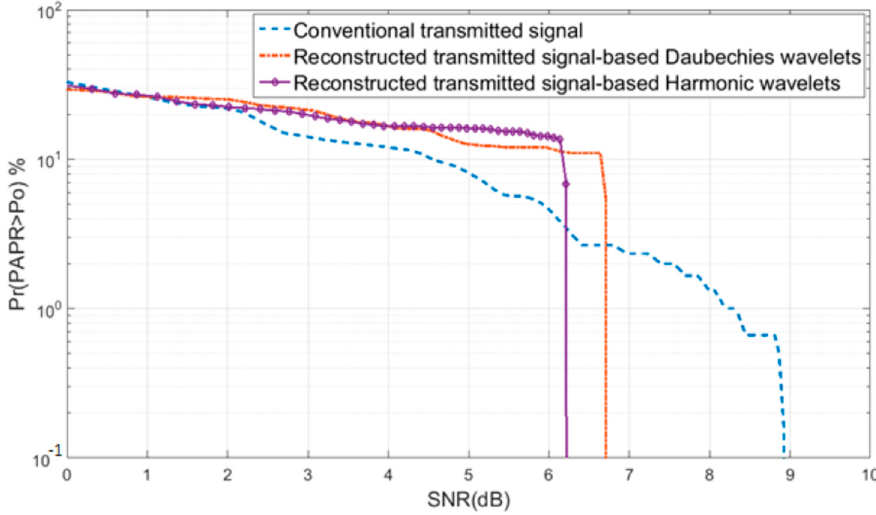
Figure 7. The comparison results based on CCDF curves.